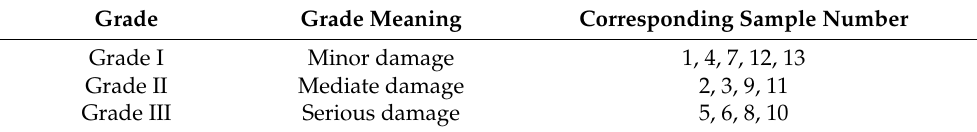
Table 16. Grade classification of TVG. Grade